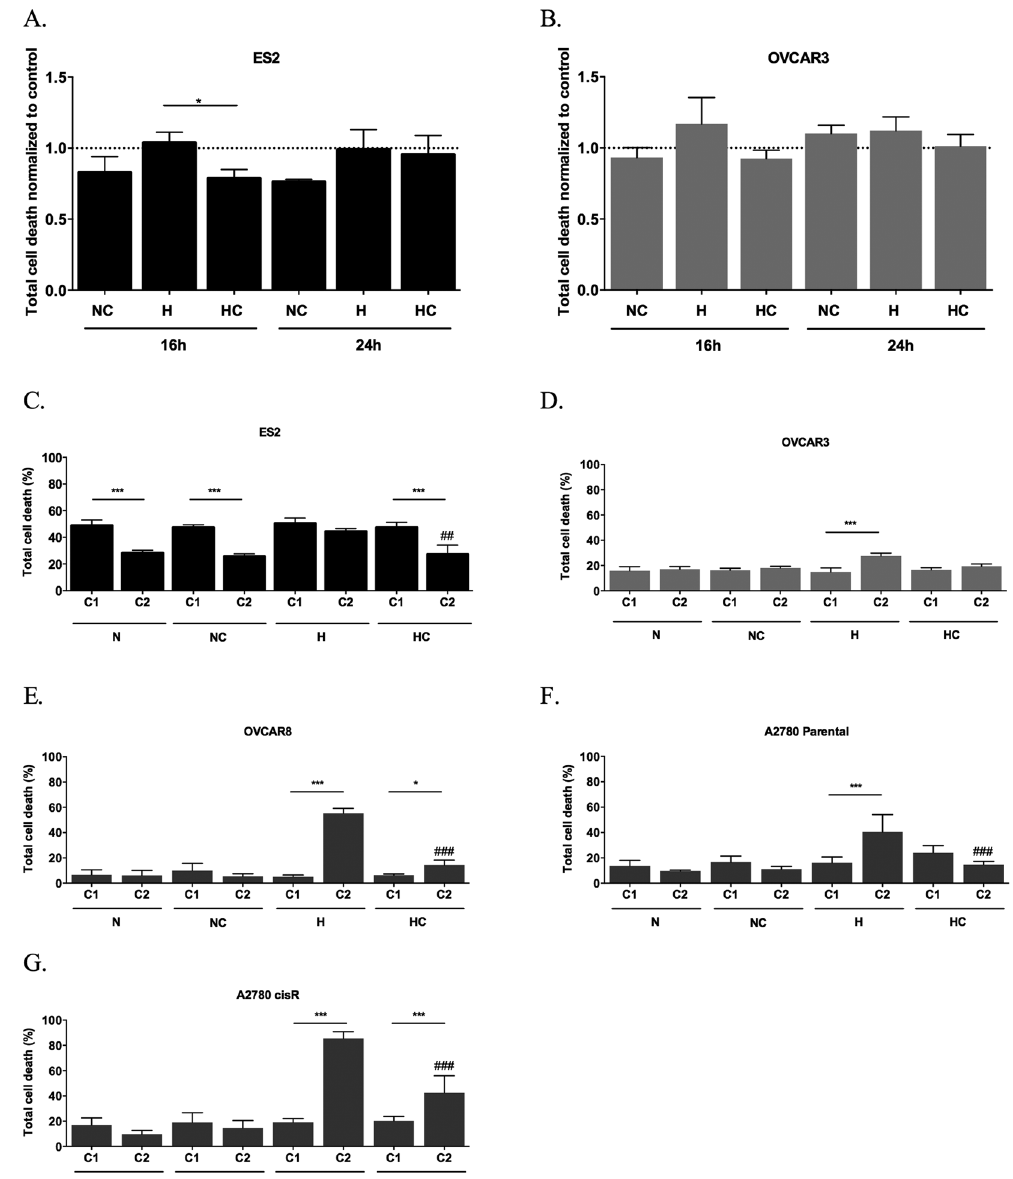
Figure 1. Cysteine has a widespread protective effect under hypoxia in ovarian cancer cells. Total cell death normalized by control for 16 and 24 h of assay for ( A ) ES2 cells and ( B ) OVCAR3 cells and total cell death in the first cycle (C1) and in the second cycle (C2) of treatments in ( C ) ES2, ( D ) OVCAR3, ( E ) OVCAR8, ( F ) A2780 parental cells and ( G ) A2780 cisR cells. N - Normoxia; NC - Normoxia supplemented with cysteine; H - Hypoxia; HC - Hypoxia supplemented with cysteine. Results are shown as mean ± SD. Cardinals represent statistical significance among hypoxia with and without cysteine supplementation within the same cycle of treatments. * p < 0.05, ** p < 0.01, *** p < 0.001 (One-way ANOVA with post hoc Tukey